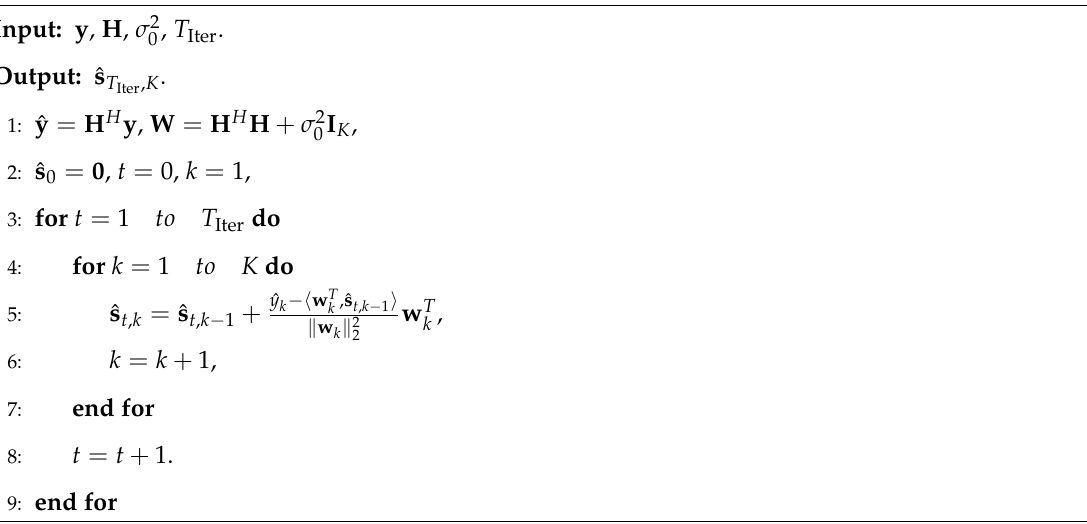
Algorithm 1 Kaczmarz algorithm based signal